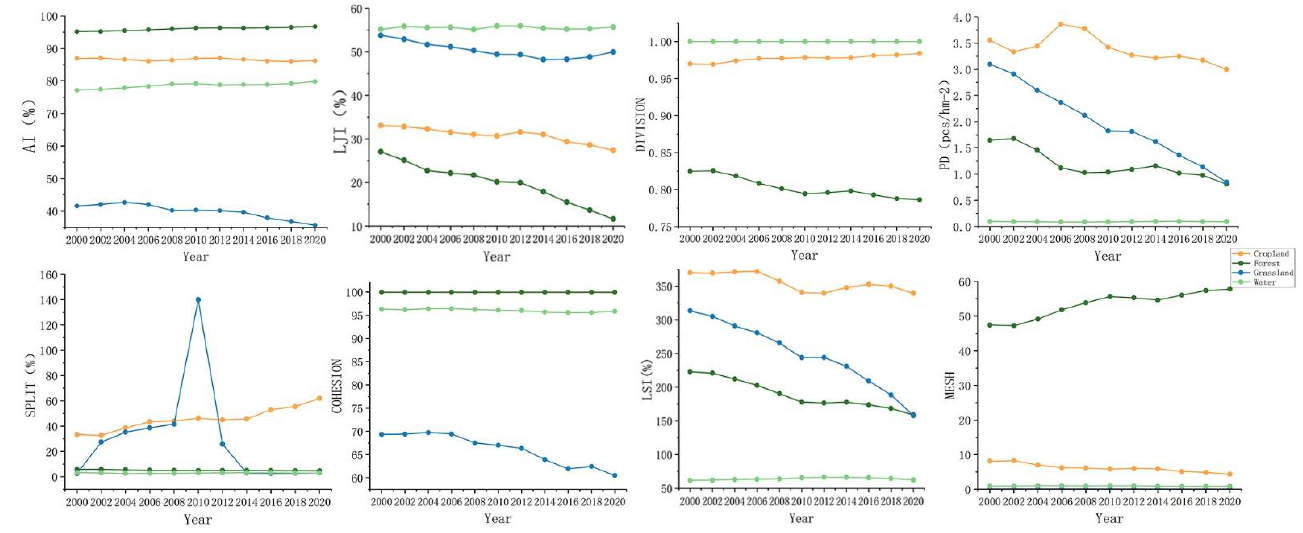
Figure 7. Change in landscape level index in Nanhu Scenic Area from 2000 to 2020.